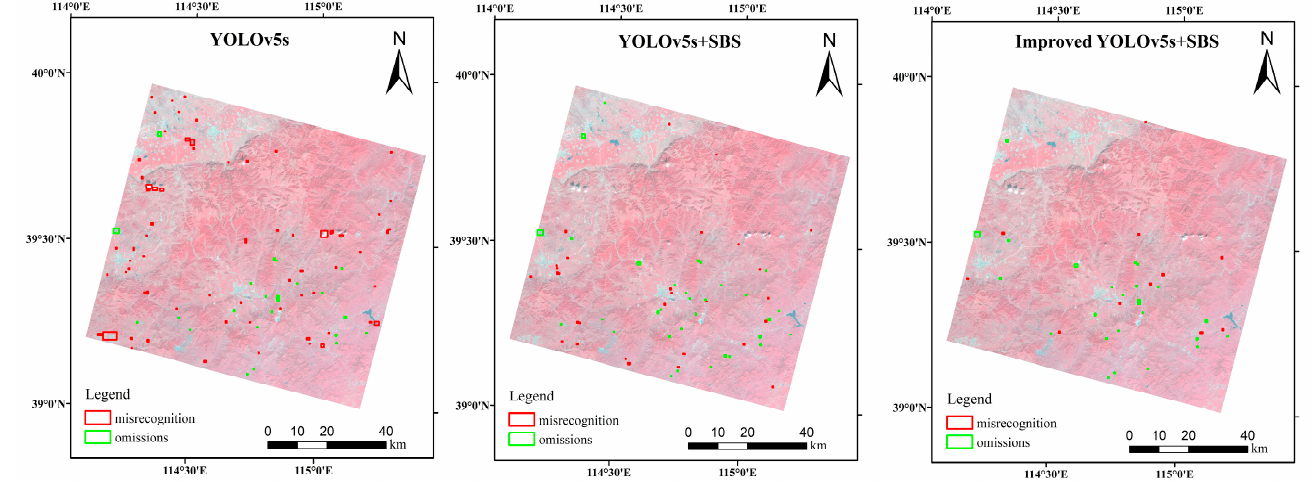
Figure 16. Overall comparison of the three models. The satellite images are treated with semi-transparency to highlight the comparison results.